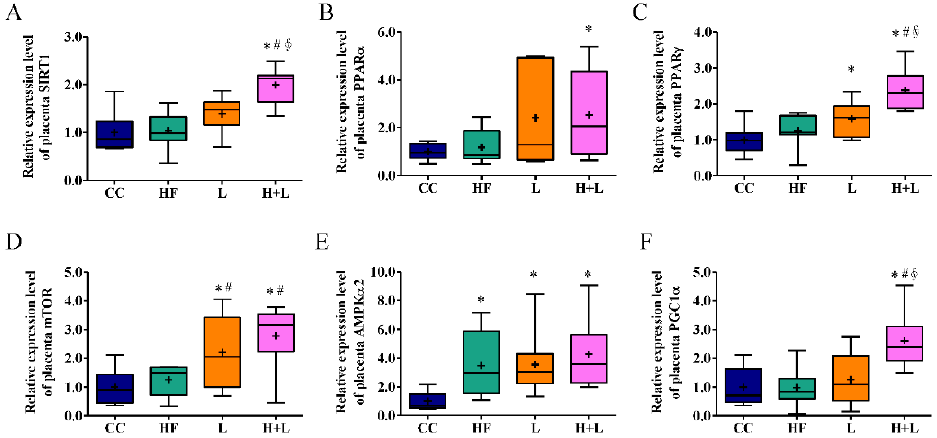
Figure 7. Gene expressions of nutrient sensing molecules of placenta tissue. ( A ) SIRT-1 ( B ) PPAR α ( C ) PPAR γ ( D ) mTOR ( E ) AMPK α 2 ( F ) PGC1 α mRNA expressions in placenta tissue with maternal control diet (CC), maternal high-fat diet (HF), maternal control diet with prenatal Lactobacillus reuteri (L) treatment, or maternal high-fat diet with prenatal Lactobacillus reuteri treatment (H + L). The mRNA expression is shown in the relative fold. * compared to the CC group, p < 0.05; # compared to the HF group, p < 0.05; ∮ compared to the L group, p < 0.05. SIRT1, Sirtuin 1; PPAR α , Peroxisome proliferator-activated receptor α ; PPAR γ , peroxisome proliferator-activated receptor γ ; mTOR , mammalian target of rapamycin; AMPK α 2 , AMP-activated protein kinase; PGC1 α , peroxisome proliferator-activated receptor gamma coactivator 1 α . The diagram shows the mean level (cross symbol) “+”.